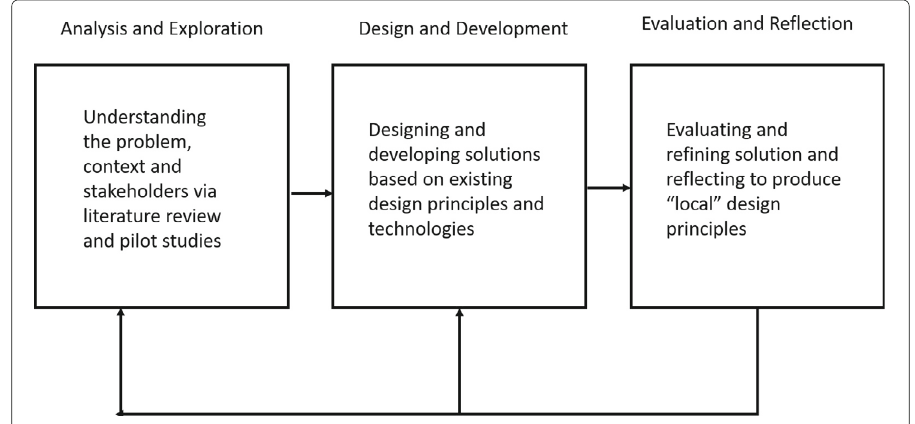
Fig. 1 Design-based research as applied in this research work. This figure describes how we applied design-based research methodology in this